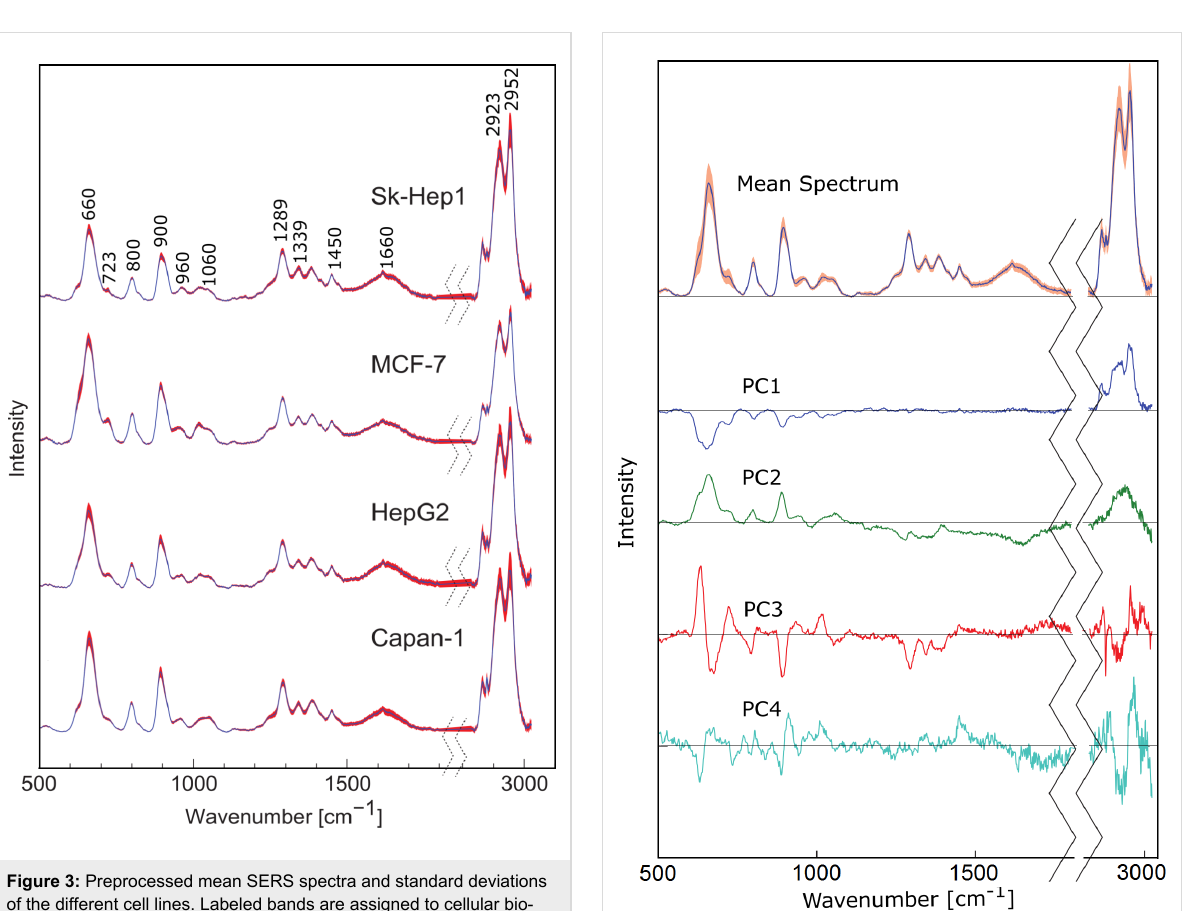
The score values of the first four PCs are plotted in Figure